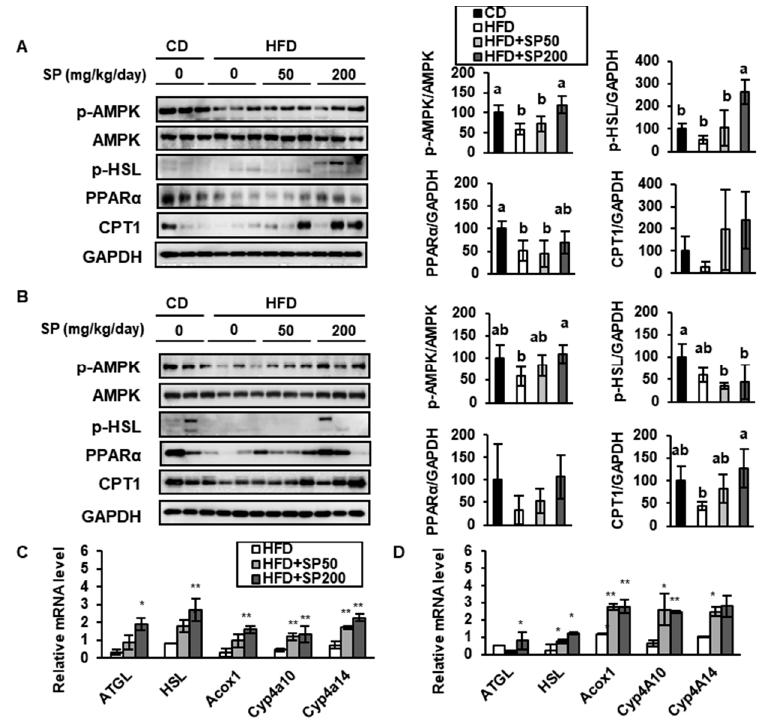
Figure 6. Silk peptide increases fatty acid oxidation in white adipose tissue from HFD-induced obese mice. The expression of p-AMPK, AMPK, p-HSL, PPAR α , and CPT1 in ( A ) sWAT and ( B ) vWAT was determined by western blotting. Values with di ff erent letters were significantly di ff erent; p < 0.05 (a > ab > b). The expression of fat metabolism genes in ( C ) sWAT and ( D ) vWAT was measured using qRT-PCR. Data are expressed as mean ± SD ( n = 8). * p < 0.05 and ** p < 0.01 indicates significantly di ff erence from HFD